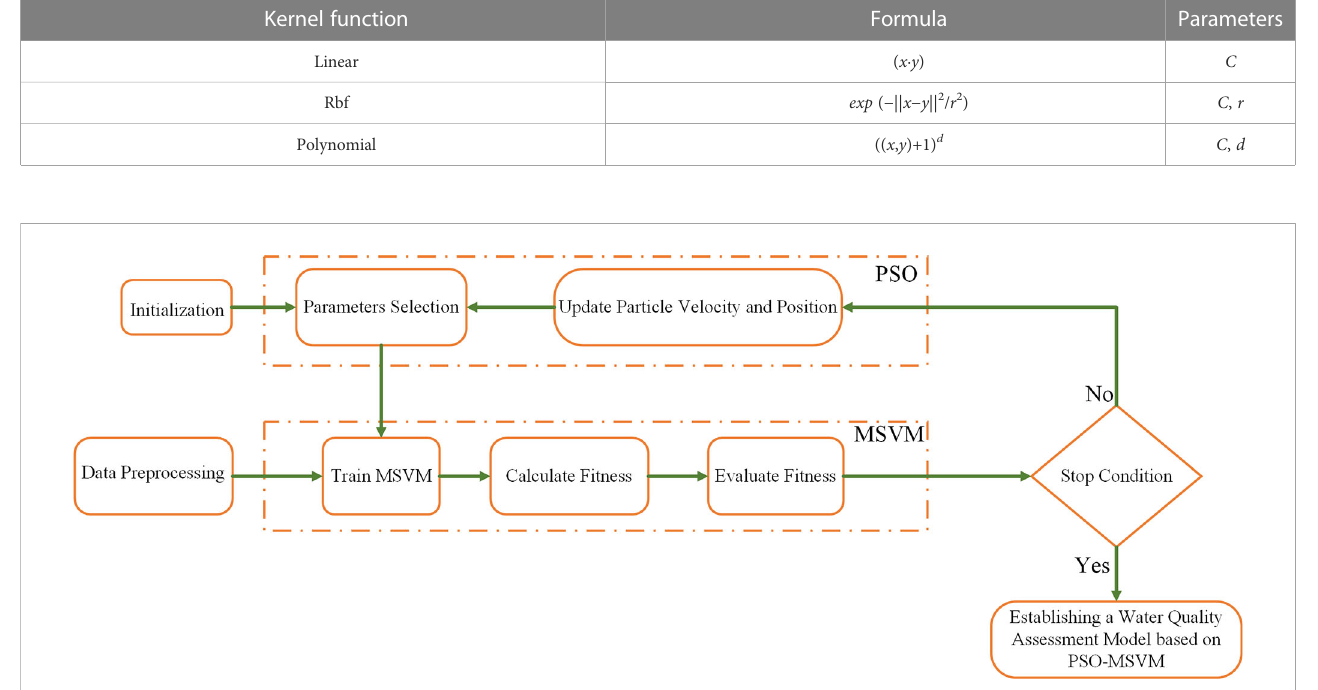
FIGURE 2 Flowchart of PSO-MSVM parameter